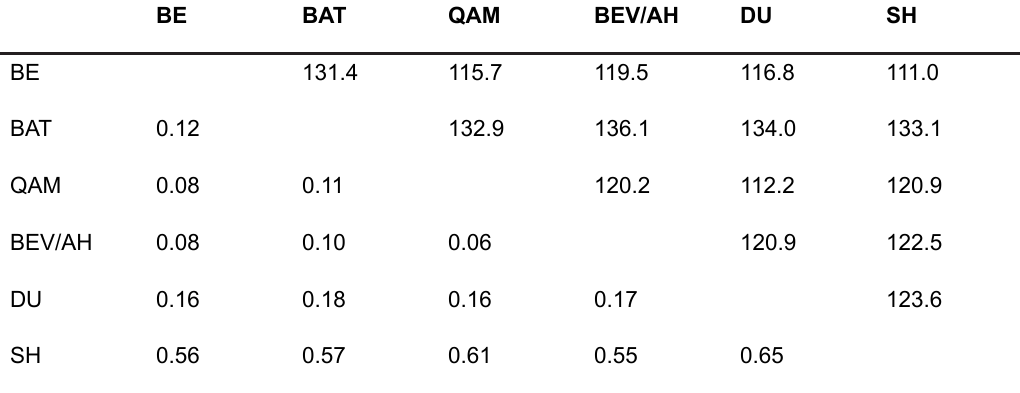
Table 3. Genetic distances between pairs of subpopulation locations. Average-square distance 1 (ASD) is above the di- agonal; Nei’s standard genetic distance 2 (D ) is below the diagonal. For explanation of abreviations of studied caribou S herds, please see Table